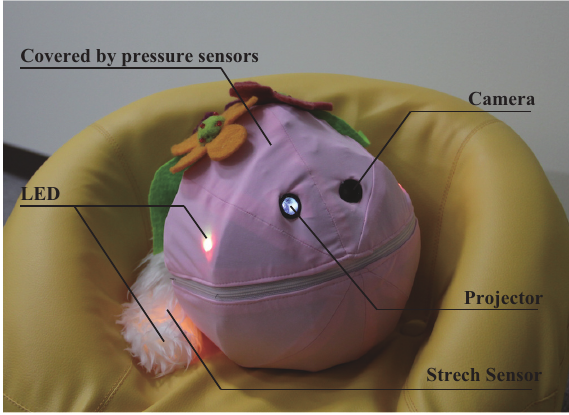
Figure 1. Pepita: a huggable robot companion with caricatured appearance.